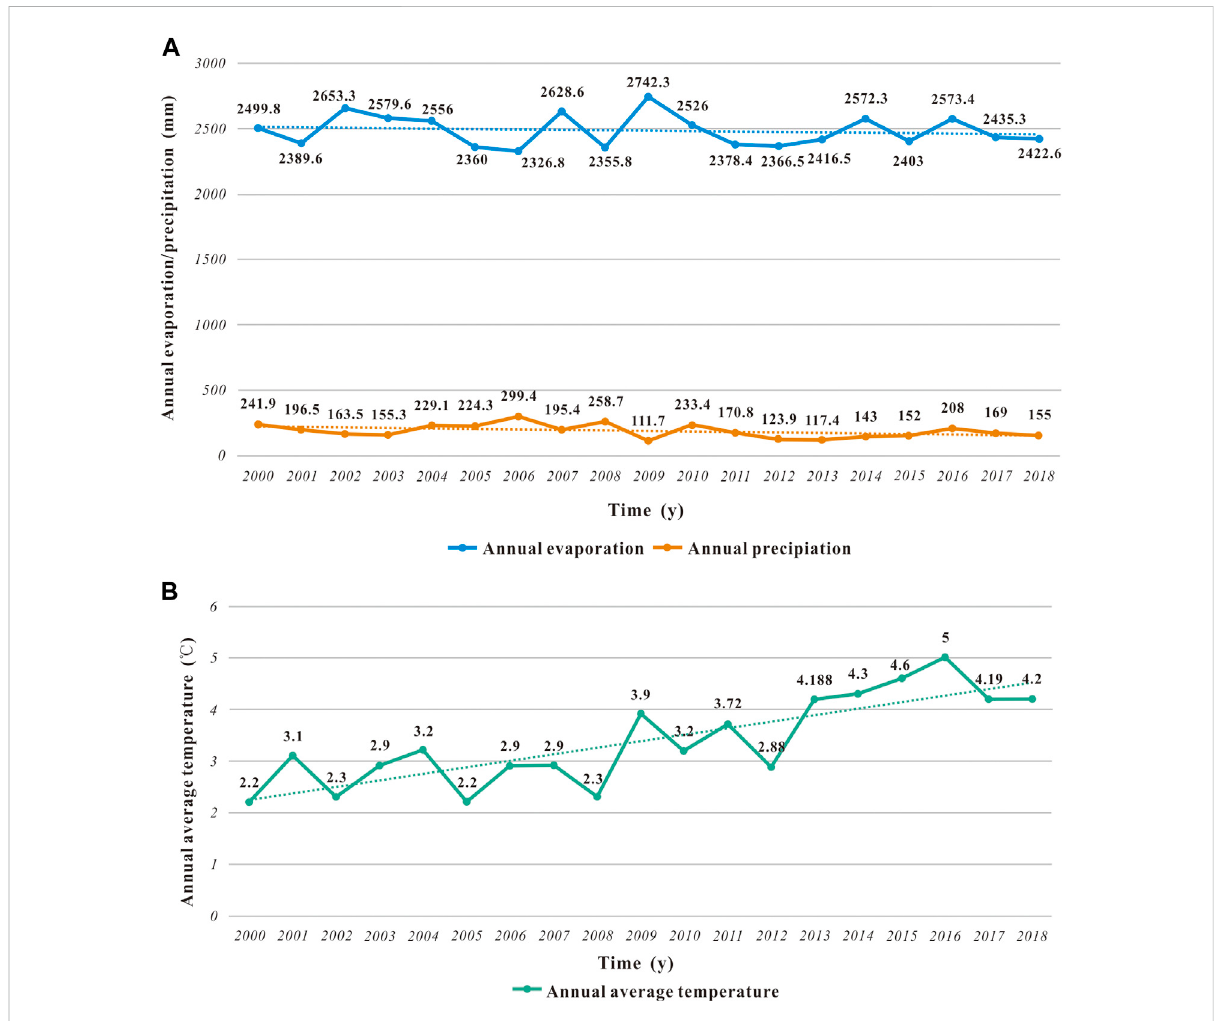
FIGURE 7 Evaporation,precipitationandtemperaturechangesinZabuyeSaltLakefrom2000to2018. (A) Evaporationandprecipitationtrendsfrom2000 to 2018; (B) Temperature trend from 2000 to